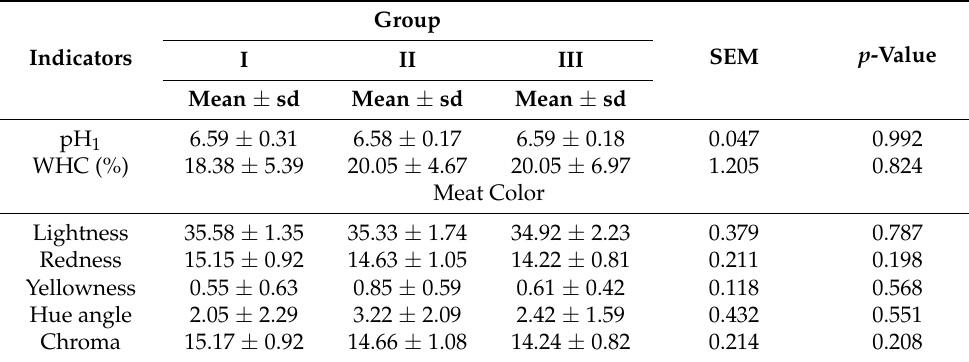
Table 5. Physical properties of lamb